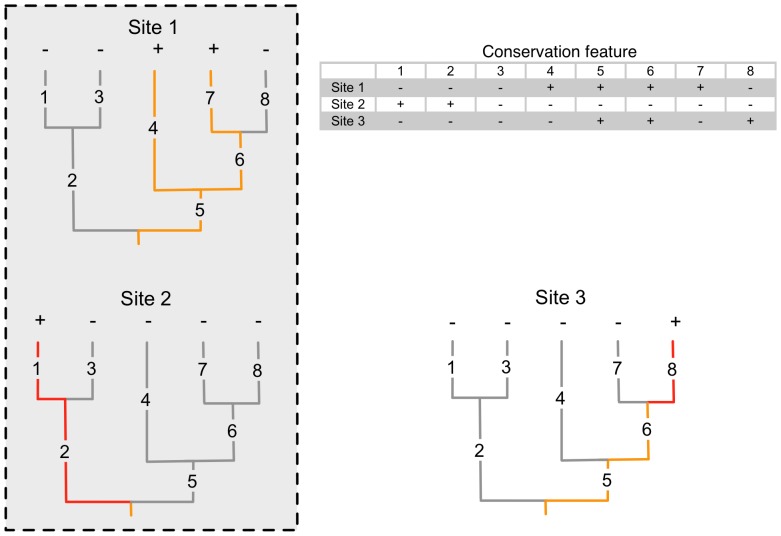
Interpretation of phylogenetic tree branches as features and its application to conservation planning.Tips of a phylogenetic tree are marked with + (presence) or - (absence) to indicate their representation for each of three sites. The subtree (in colour) that connects this set of tips to the root consists of a set of branches (numbered 1–8) that, when summed, constitutes the phylogenetic diversity of that site. Each of these branches are coded in the table as conservation features that are either present or absent for each site based on the presence or absence of the relevant tips. Branches marked in orange are represented in Site 1 while red branches are not represented in Site 1. Site 2 is the most complementary to Site 1 as it adds the most new features (and branch length). Therefore, in a scenario where Site 1 is already protected and only one other site can be chosen for protection, Site 2 should be added to the protected set (indicated by the grey box).